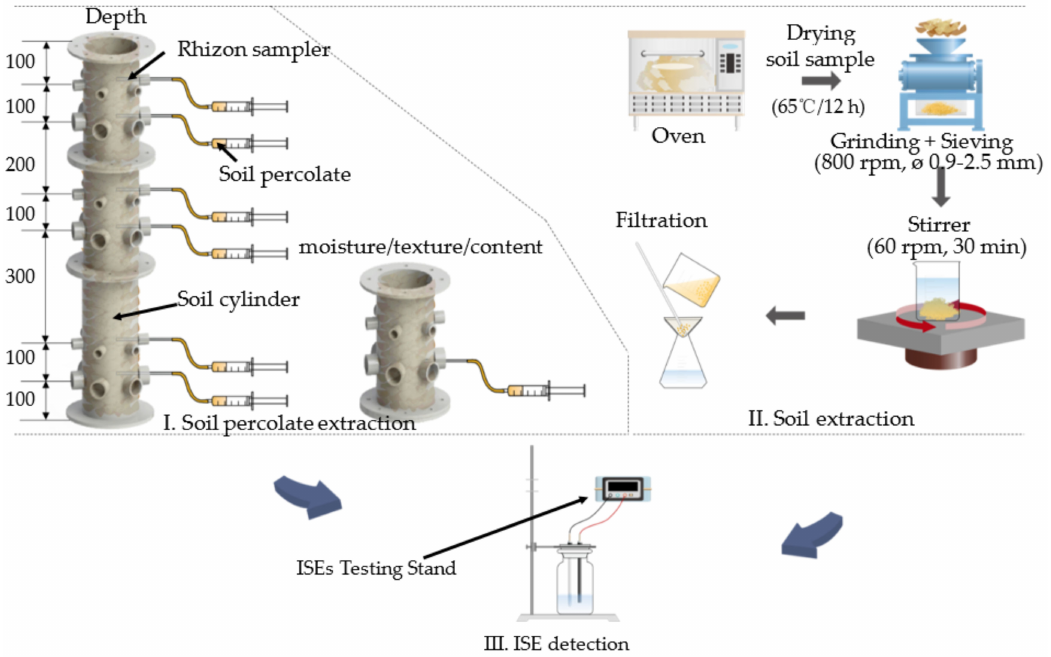
Figure 3. The schematic of ISE-based in-situ / laboratory soil NO 3 − -N